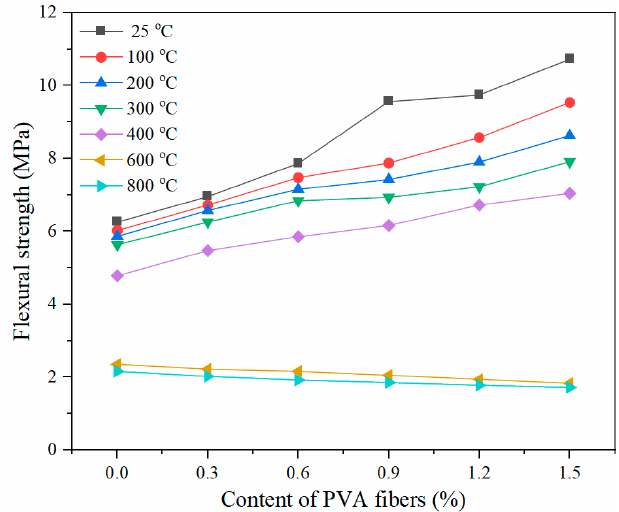
Figure 10. Flexural strength of PVA-FRCC after exposure to different temperatures.